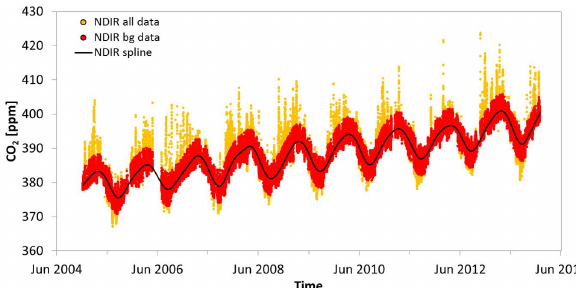
Figure 1. In situ CO 2 mole fractions of the NDIR measurements as a function of time in ppm at JFJ: all hourly averages before filtering (yellow), hourly averages after filtering (red), and the spline (black line). Note that the yellow points correspond to only about 5% of the whole data